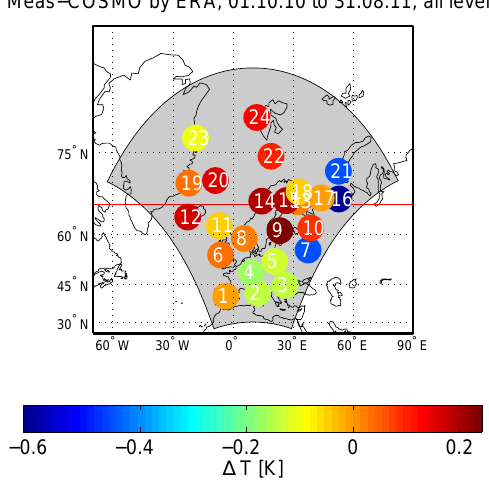
Figure 9. Mean difference of model values and measurements of temperature for each station over all levels when using ERA-Interim as forcing data. The picture is similar when using NCEP reanalysis data.